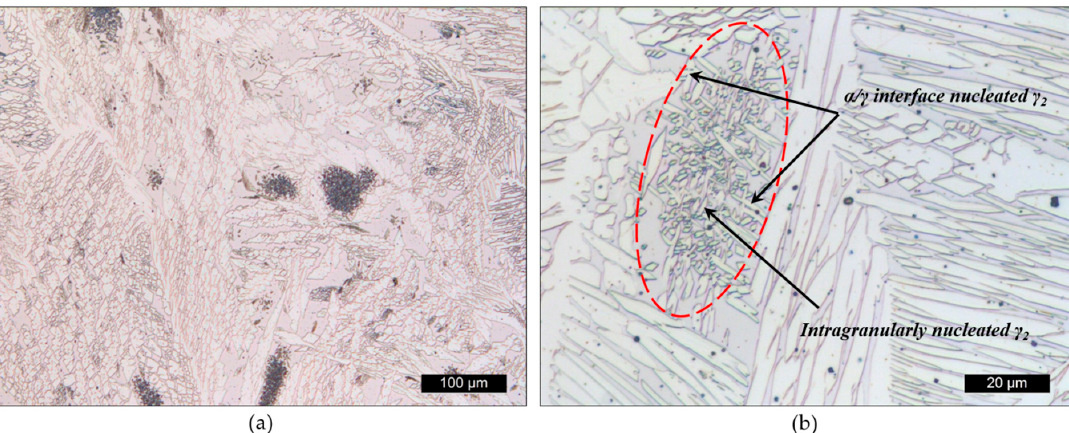
Figure 16. Secondary austenite formed in the ferrite, ( a ) overview with dark islands of γ 2 , and ( b ) close-up with γ 2 inside the dotted red ellipse. Arrows point at different nucleation sites.